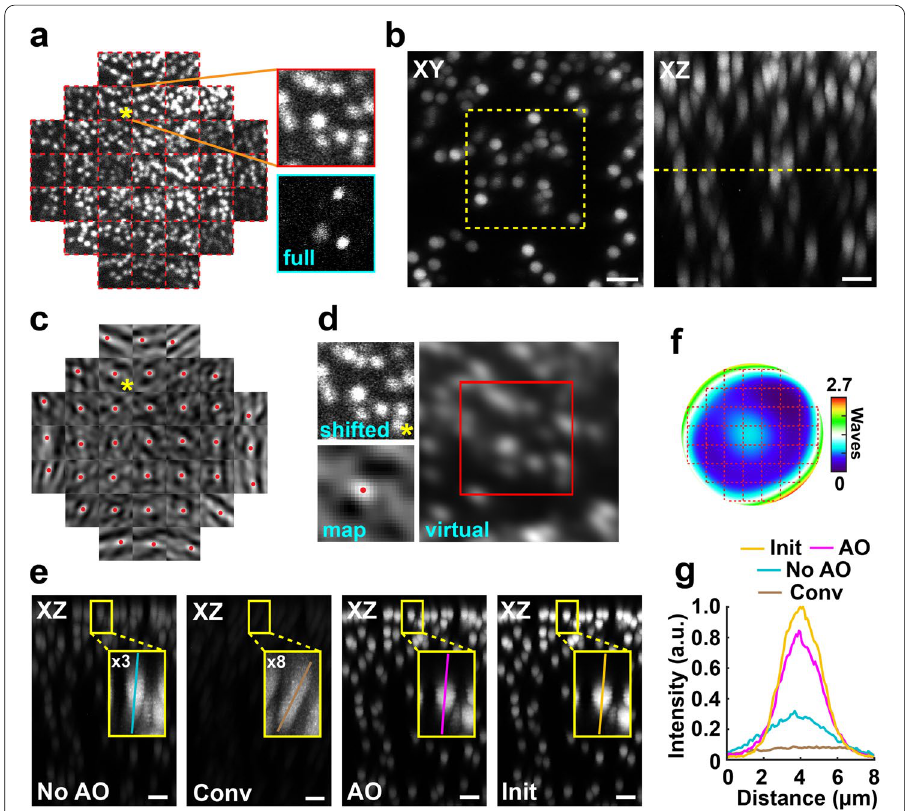
Fig. 2 Virtual-imaging-assisted AO enables aberration correction for dense 2 μm fluorescent beads. a Shifted images acquired under zonal illumination and image acquired under full-pupil illumination. The entire wavefront is split into an array of segments (red dashed squares), and the acquired shifted images are arranged by the corresponding wavefront segment. The image marked by the cyan square was acquired under full-pupil illumination with the same FOV as the shifted images, and it was used as the reference image in the conventional method. b Maximum intensity projection of the captured image volume, which serves as the sample in virtual imaging. The yellow dashed box in the lateral view marks the imaging FOV during zonal illumination. The yellow dashed line in the axial view indicates the objective focal plane during the aberration measurement process. c Maps of structural similarity with respect to the shift. In each map, the shift with the largest similarity is marked by the red dot. d Shifted image, reference image and similarity map for a representative wavefront segment marked by the yellow asterisks in ( a) and ( c ). The red box indicates the patch of the reference image exhibiting the largest similarity with the shifted image. e Maximum intensity projection of the image volume without AO correction (No AO), with AO correction using the conventional method (Conv) and our method (AO), and under the initial condition where no artificial aberration is applied (Init). The insets in the images without AO correction and with AO correction using the conventional method are digitally enhanced 3-fold and 8-fold, respectively, to increase the visibility. f Corrective wavefront. The dashed squares indicate the layout of the wavefront segments, where each wavefront segment corresponds to a unit square. An independent mask approach was used in the measurement process. g Signal profiles along the cyan, brown, magenta and orange lines in e . Scale bars, 5